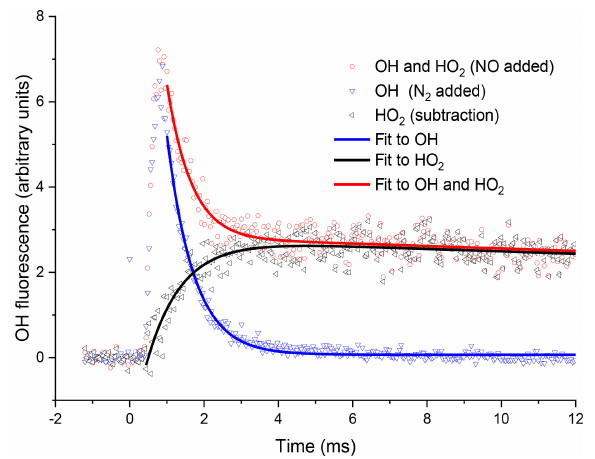
Figure 4. Examples of OH fluorescence traces collected at the sec- ond detection axis under the same conditions for Fig. 3. The blue triangles are where N 2 has been injected through the pipe, i.e. no HO 2 -to-OH conversion. The OH signal profile differs from that in Fig. 3, with k OH , 2nd = ( 1390 ± 44 ) s − 1 (2 σ errors), additionally, there is a time delay to peak OH, representing the transport time (primarily the time taken to travel from the breakdown of the jet to the second detection axis). The red circles are the OH signal ob- tained with NO injection. At short times the signal is dominated by reactant OH, but at times greater than 2ms, the signal is dominated by OH titrated from the HO 2 product. The resultant OH trace as- sociated with HO 2 formation in the high-pressure cell obtained by subtracting the two OH traces, obtained with either NO or N 2 injec- tion prior to the second detection axis, shown as black triangles, and a bi-exponential growth and decay fit, black curve, gave a formation = ( 1080 ± 150 ) s − 1 (2 σ rate coefficient, k HO 2 , 2nd